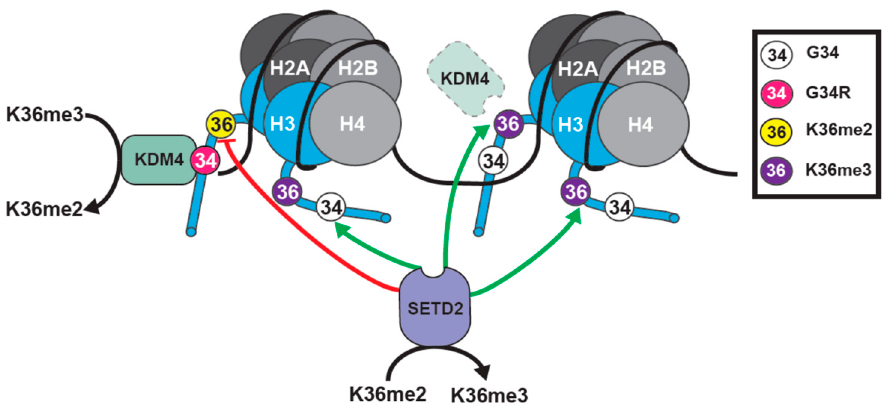
Figure 5. Model representing H3.3 G34R function. (1). G34R blocks SETD2 activity on the mutant histone tail. SETD2 activity on other H3 tails is unaffected. (2). KDM4 is sequestered by G34R mutant H3, enhancing K36me3 demethylation to K36me2 on the mutant tail. Further, loss of KDM4 from its